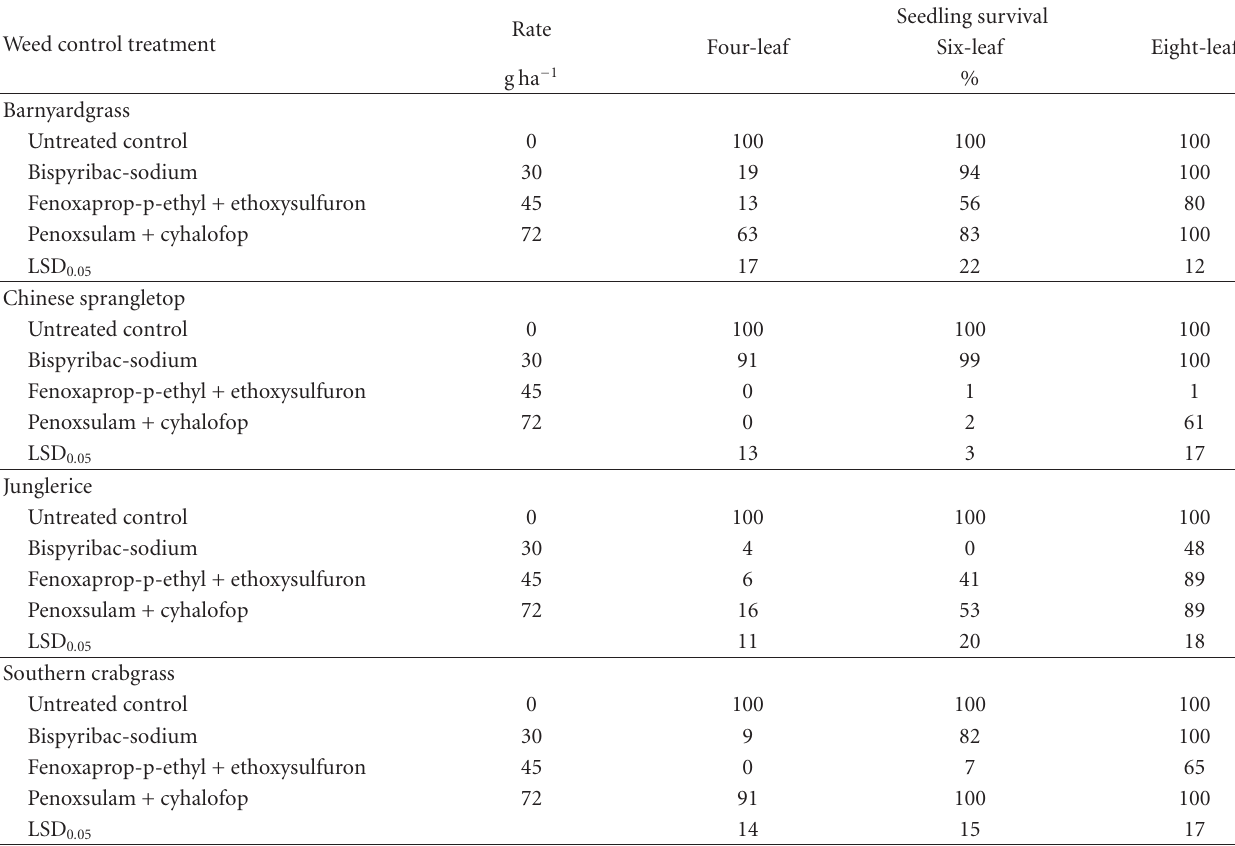
Table 1: E ff ect of postemergence herbicides on seedling survival (%) of barnyardgrass, Chinese sprangletop, junglerice, and southern crabgrass when sprayed at their four-, six-, and eight-leaf stage. Weed control